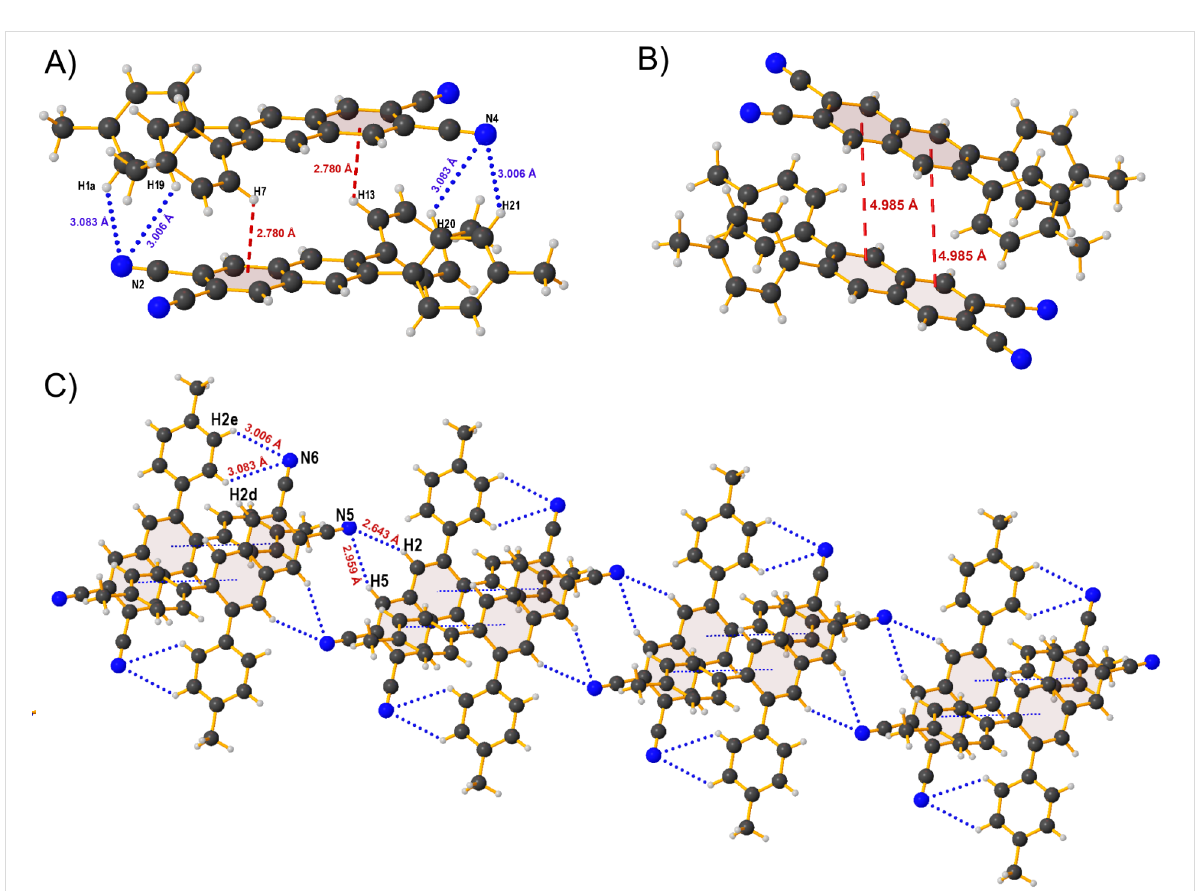
Figure 2: A) Intermolecular CH … π interactions for compound Me . B) Weak intermolecular π – π stacking interactions. C) Packing of compound Me along the a -axis. Color code: black = carbon, grey = hydrogen and blue = nitrogen. The unit cell is shown in Supporting Information File 1, Figure